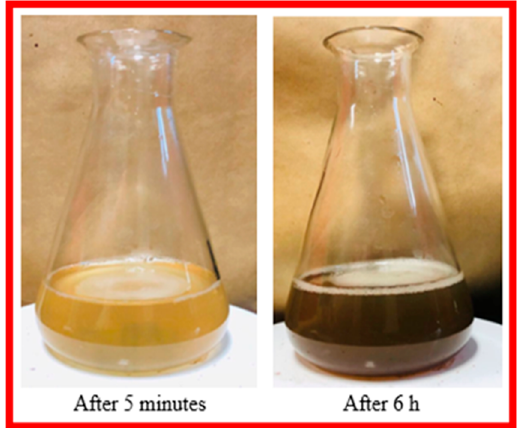
Figure 1. The color change of solution after the reduction of AgNO 3 by leaf extract.